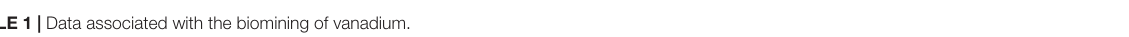
1 2 Quantity (ng) Comparison Comparison with control with quantity (%) in basalt (%) x 10 −